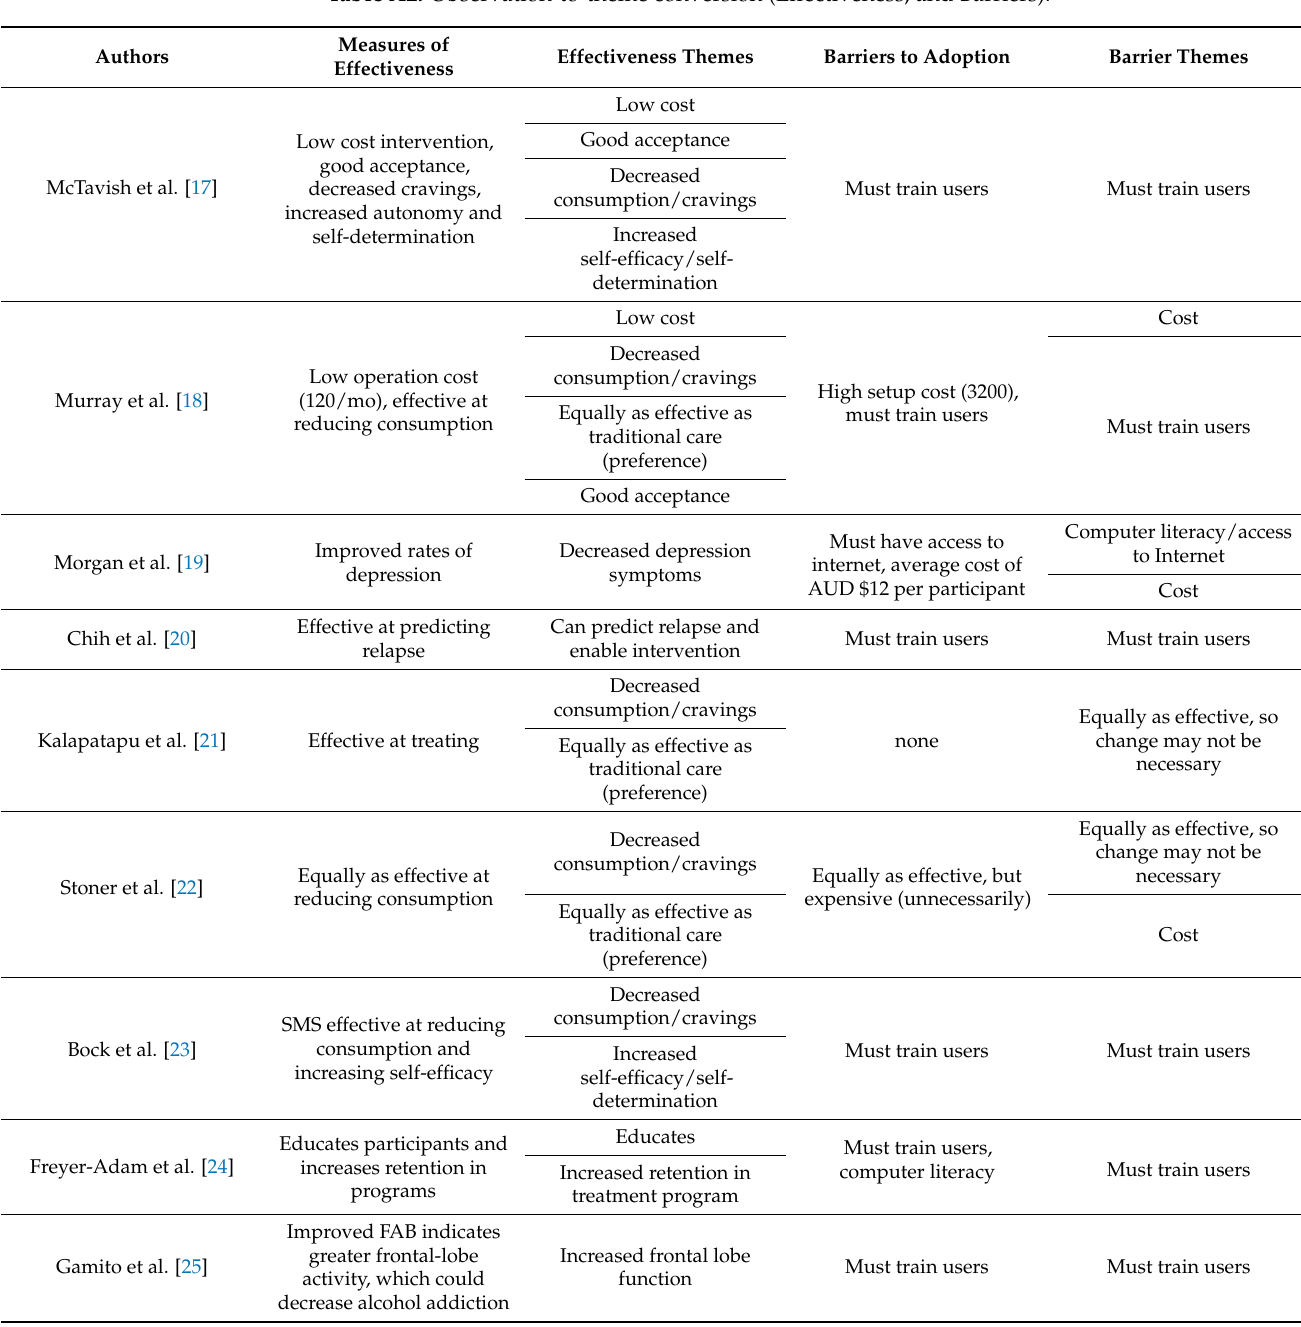
Table A2. Observation-to-theme conversion (Effectiveness, and